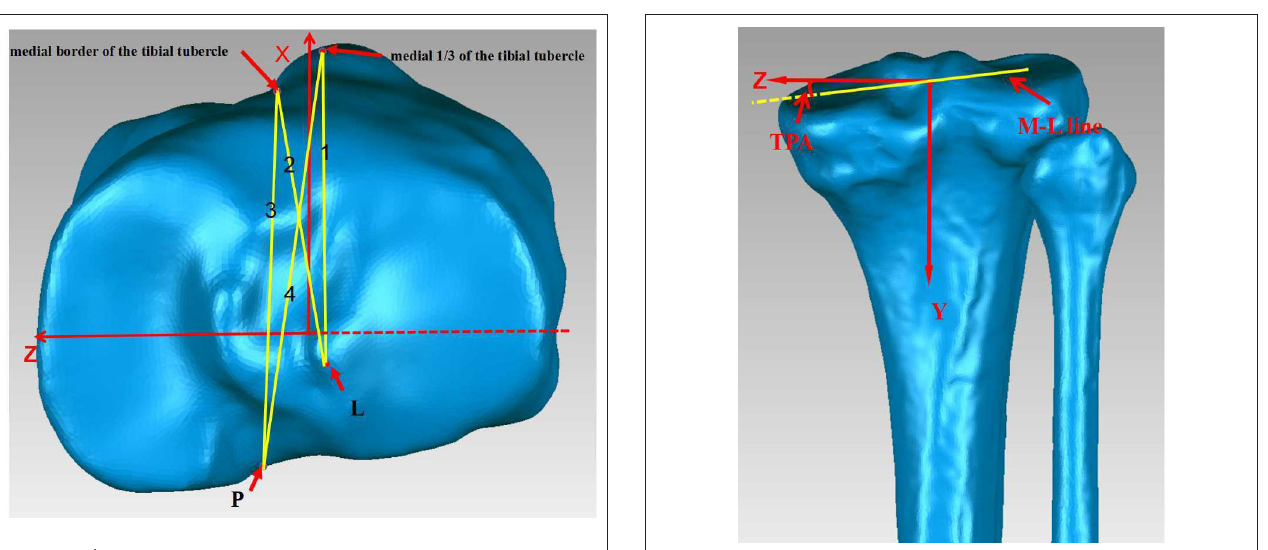
3.20 ± 2.04 and 3.49 ± 2.81, respectively. There was no